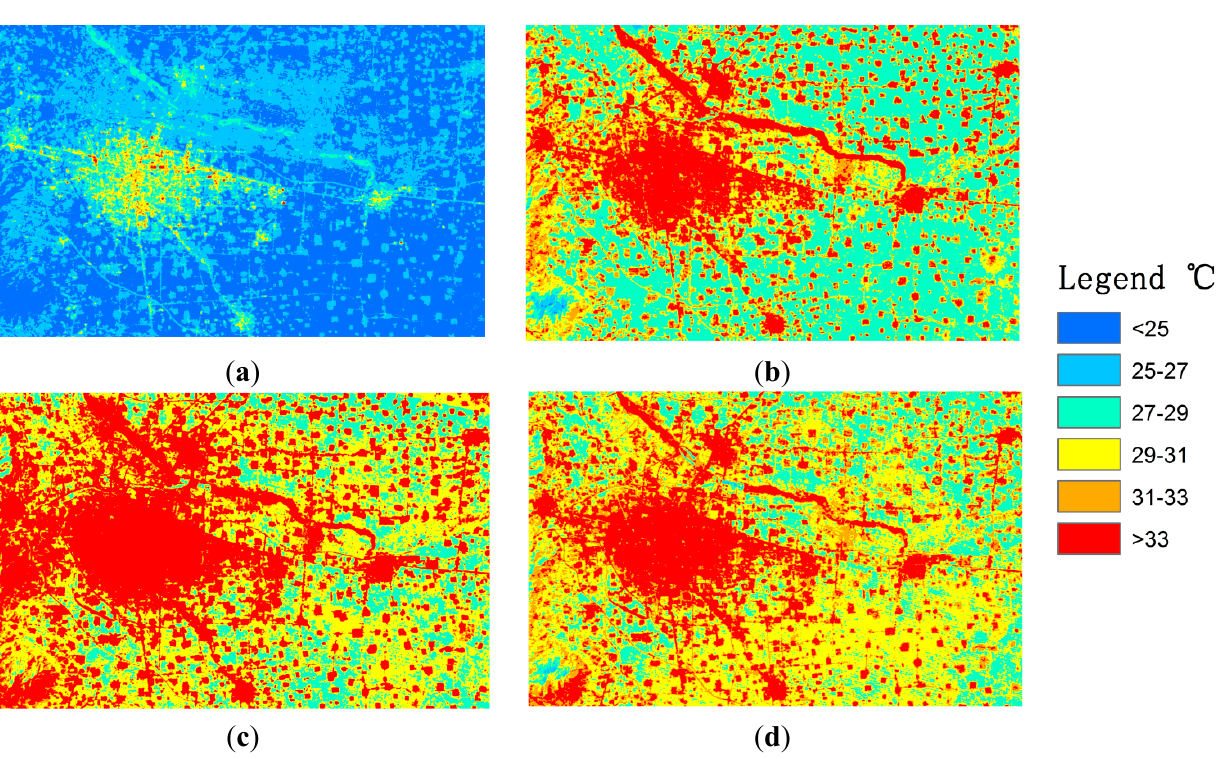
Figure 4. LST distribution in the study area derived from Landsat TM image on ( a ) 5 September 2006; ( b ) 23 August 2007; ( c ) 12 August 20 0 9; and ( d ) 15 August